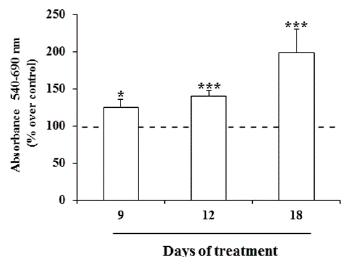
Figure 4. Effects of prolonged treatment with MeHg on cell viability. Nthy-ori-3-1 cell growth was determined by MTT assay after treatment for 9, 12 and 18 days with MeHg 0.1 µM. Results are expressed as percentage of increment vs. untreated cells, considered arbitrarily as 100 (dashed line). Results are mean ± SD of three independent experiments. Statistical analysis was performed using the Tukey – Kramer multiple comparisons test. * p < 0.05, *** p < 0.001, vs. untreated